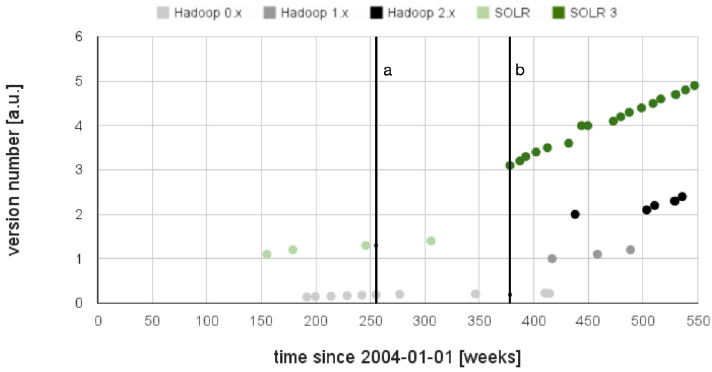
Fig 5. Version number versus release date (in weeks since 2004-01-01) for Apache Hadoop (gray) and Apache SOLR (green). The version numbers for different parallel development branches of both projects indicate ongoing improvements up to the ends of the active projects. The dates of the jump in interest derived from the plot of L.TRRI a ( t ) in Fig 4 are shown here as vertical black lines for SOLR (a) and Hadoop (b).